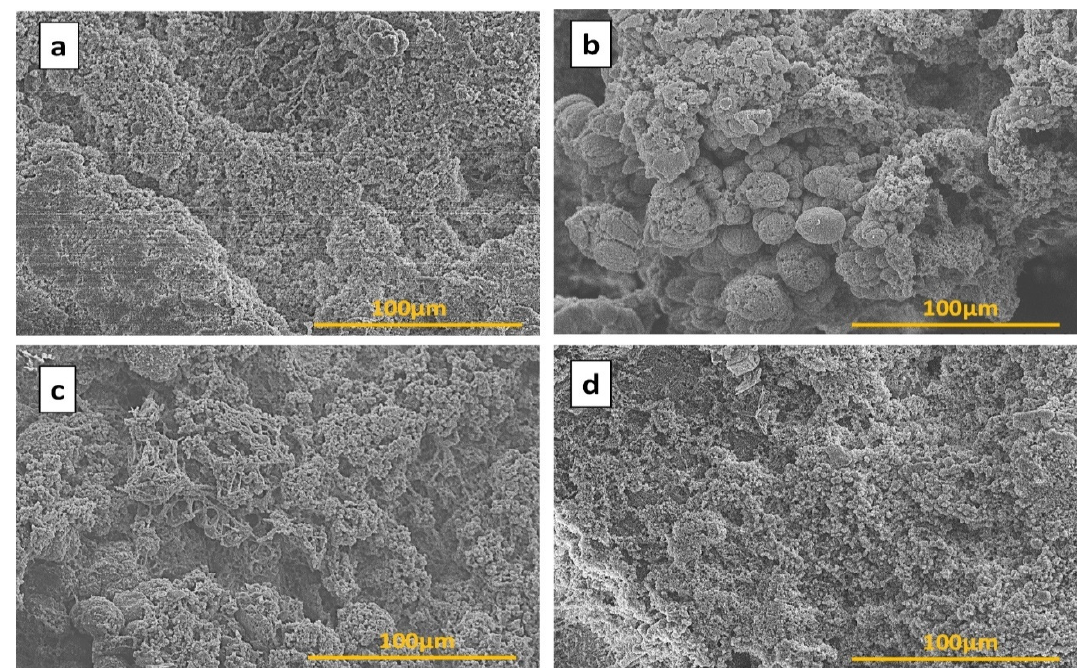
Figure 9. SEM images of ( a ) PP, ( b ), PP10L ( c ), PP10L-0.1P, and ( d ) PP10L-0.3P.